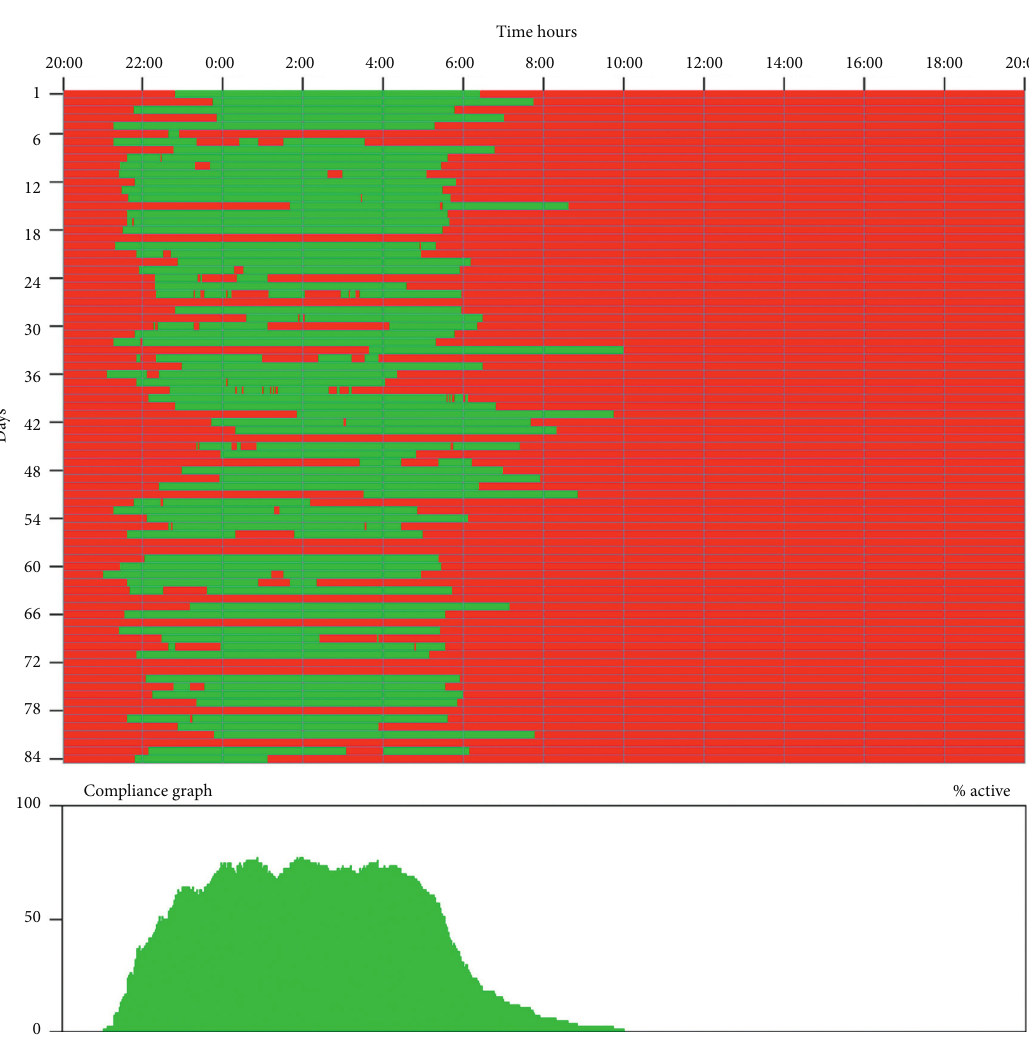
Figure 2: The mask wear information from a patient for a 3-month period. The nightly mask wear is shown as a series of horizontal green lines whose position and length tell us when and how long the patient wore the